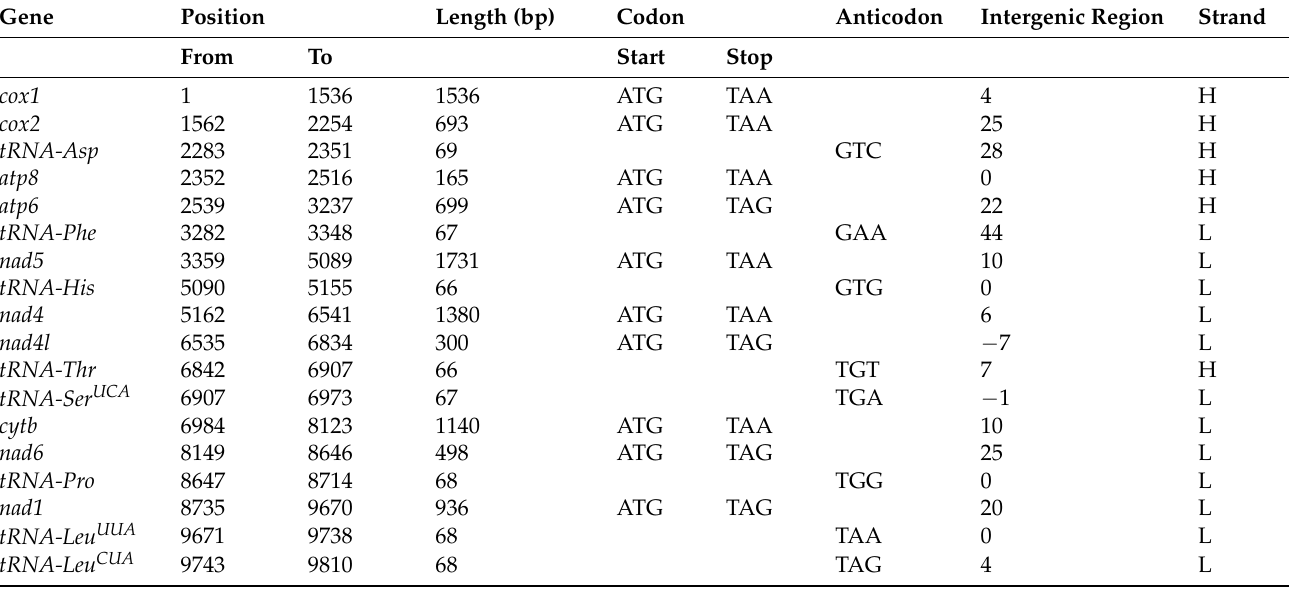
Figure 1. The mitochondrial genome map of Entemnotrochus. rumphii . From outside to inside, the first circle represents gene arrangement, the second represents the GC content, the third represents the GC skew, and the innermost circle represents the scale. The GC content circus was centered at 50% and the GC skew was centered at zero. Table 2. Organization of the mitochondrial genome of E. rumphii.